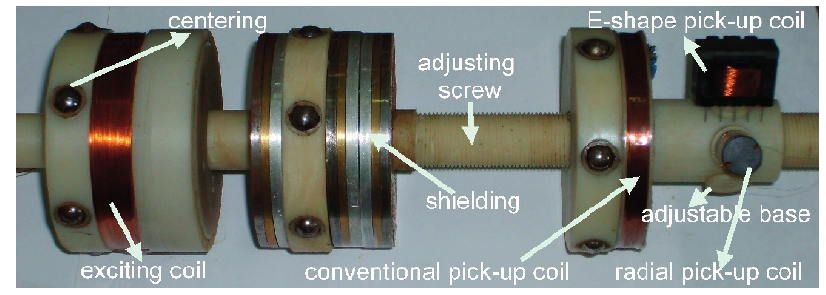
Figure 7. Composition of proposed novel